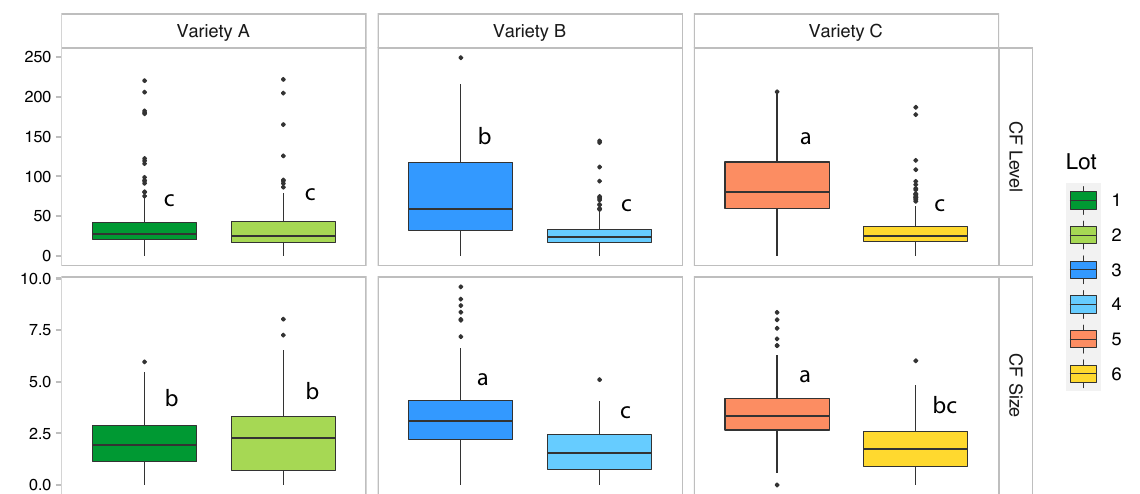
Figure 2. CF-Analyzer parameters (see Table 1) across varieties (columns) and seed lots (color-coded). Letters indicate significant differences among all lots for each parameter (rows) as calculated by ANOVA and Tukey